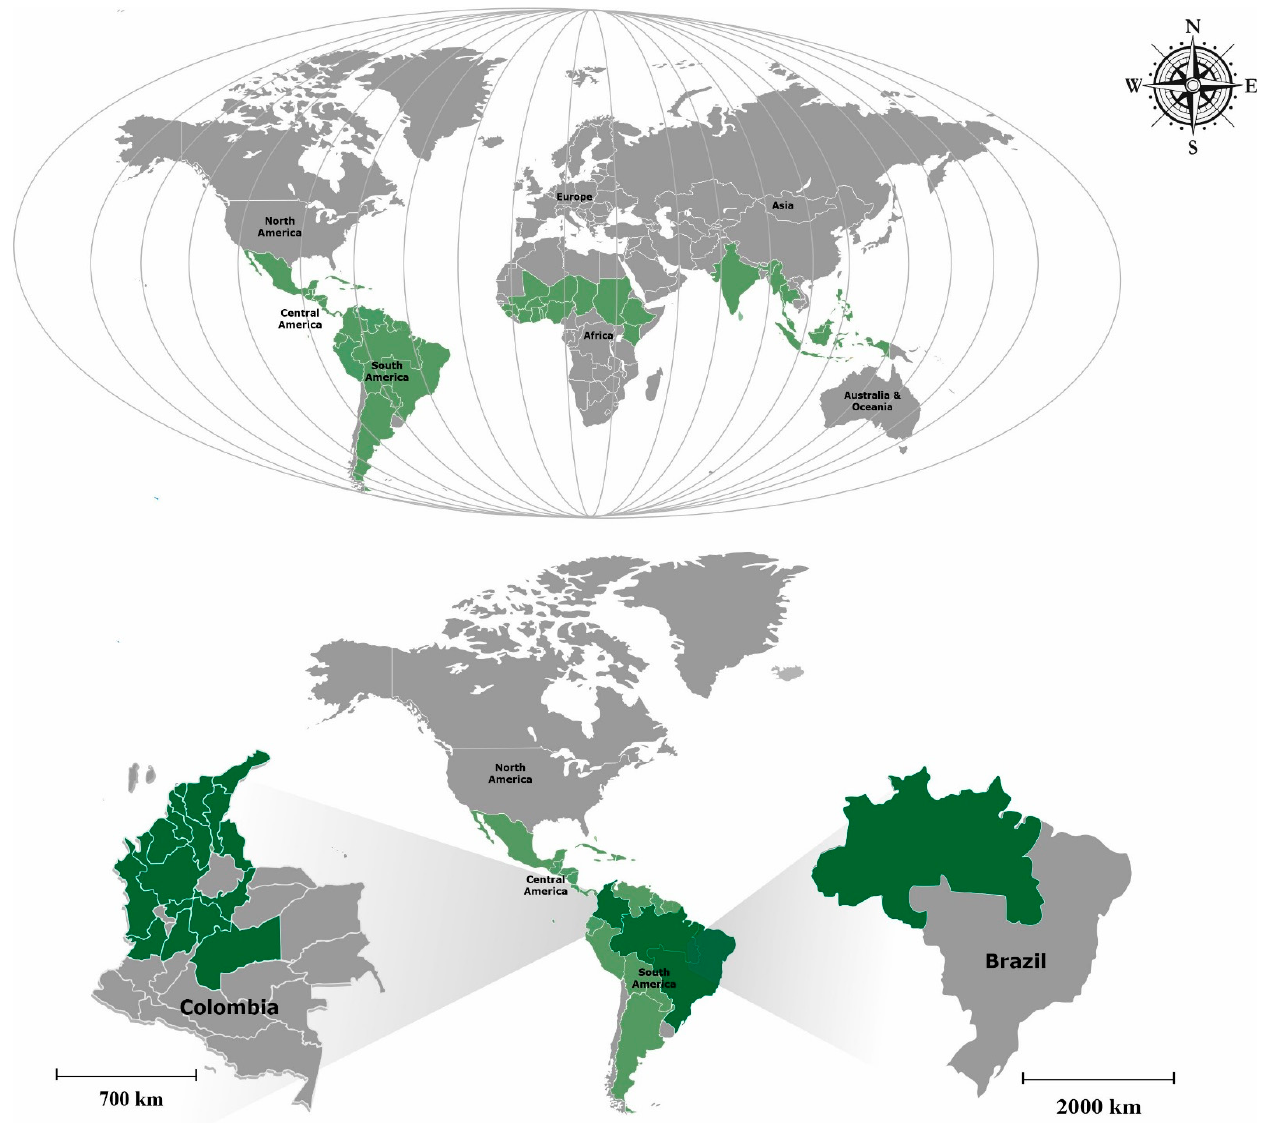
Figure 9. Geographical distribution of the genus Malachra L. Colombia and Brazil (green) countries with greater diversityThe countries of Colombia and Brazil have the largest number of species of the genus Malachra L., with six of the nine accepted names ( Malachra alceifolia Jacq.; Malachra capitata